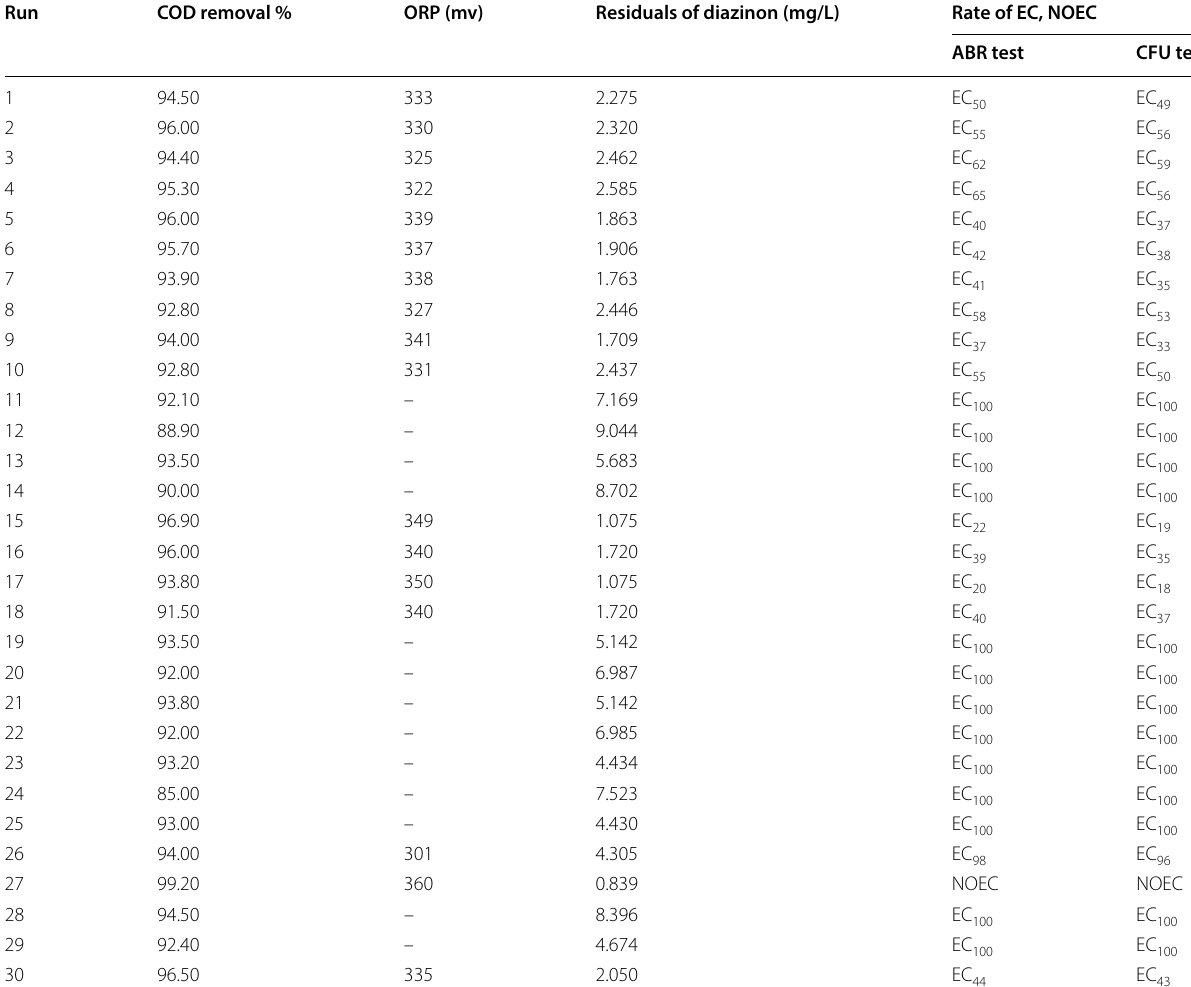
Table 8 The result of COD Removal, ORP and bioassay test to determination of effluent toxicity in different Runs Run COD removal %